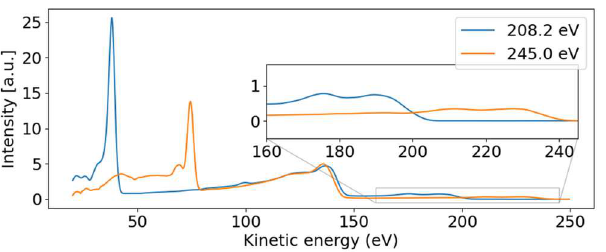
Figure 4. Photoelectron spectra for photon energies above (~245 eV) and below (~208 eV) the 2s binding energy. The dispersive behavior of the 2p photoelectron line is visible, moving from 39.8 to 74.4 eV with increasing photon energy. The 2p non-resonant Auger–Meitner band from 100 eV to 144 eV remains stable and is independent of the photon energy. The dispersive valence features are visible in the